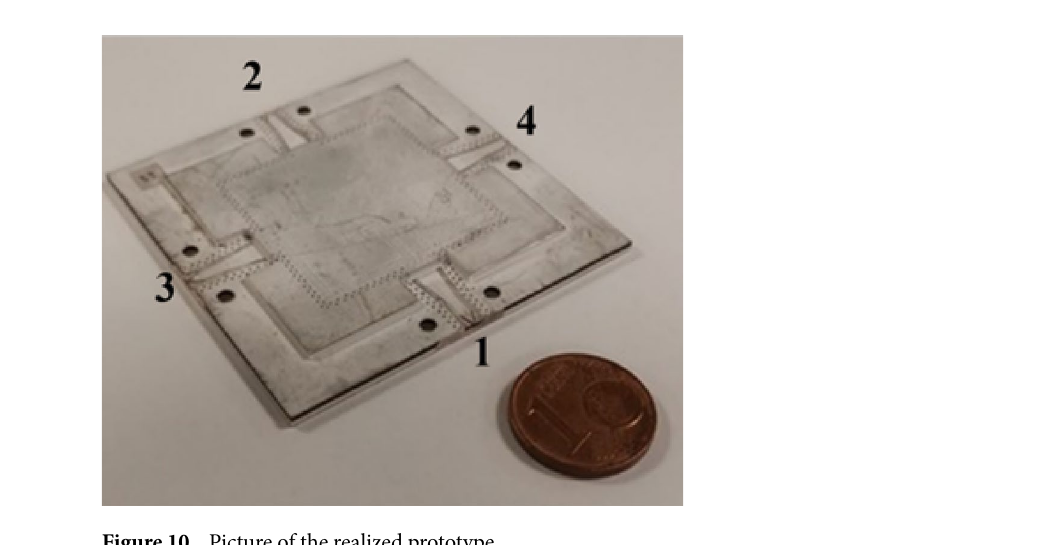
Figure 10. Picture of the realized